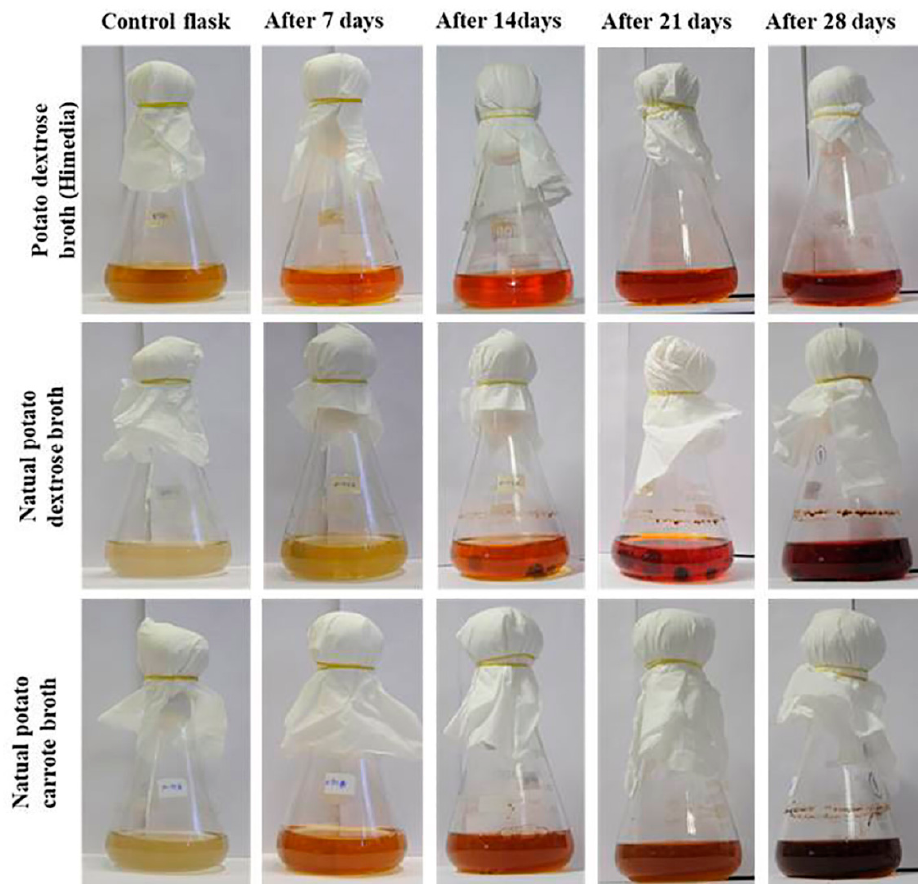
Figure 4. Analysis of pigment production by G. triuniae NFCCI 4873 in different liquid media.